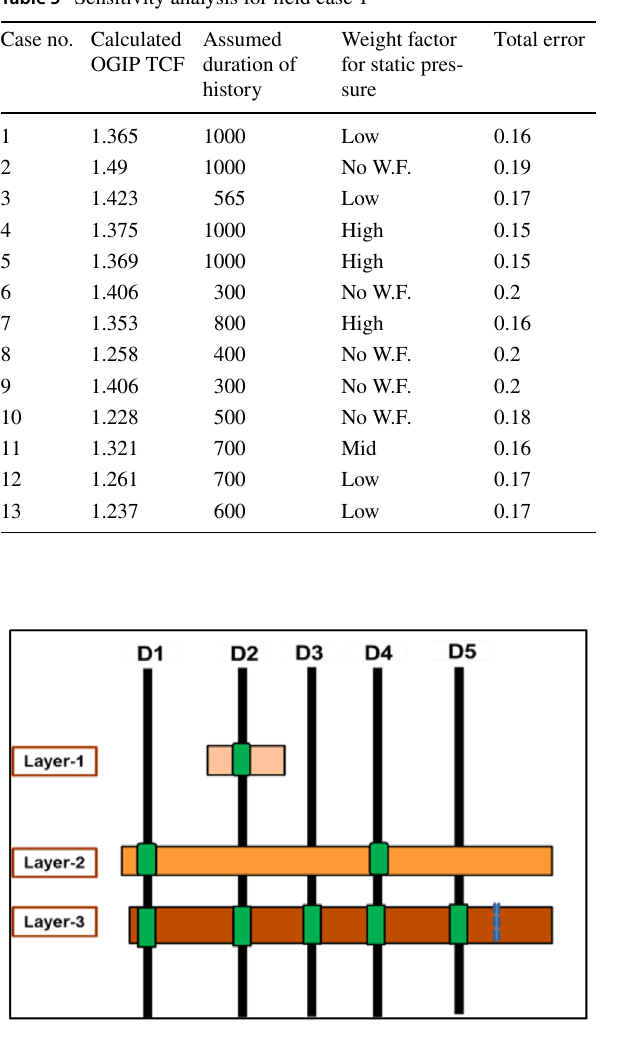
Fig. 14 Schematic of field case 2 wells completion in relation to sand layers